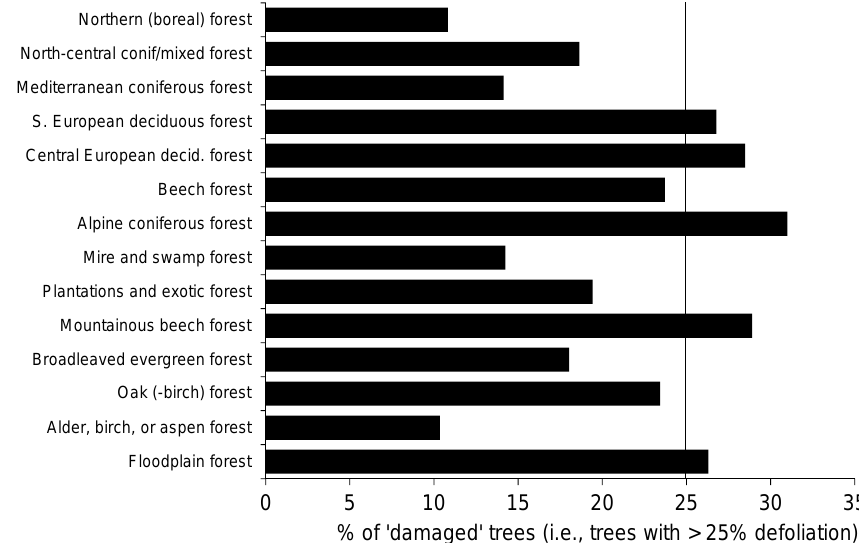
Figure 1. Fraction (%) of damaged trees (>25% defoliation) in different European forest ecosystems. The top two bars refer to the main forest types investigated in the present study. (Figure adapted from ICP Forests, Fischer et al., 2012, used with permission.)